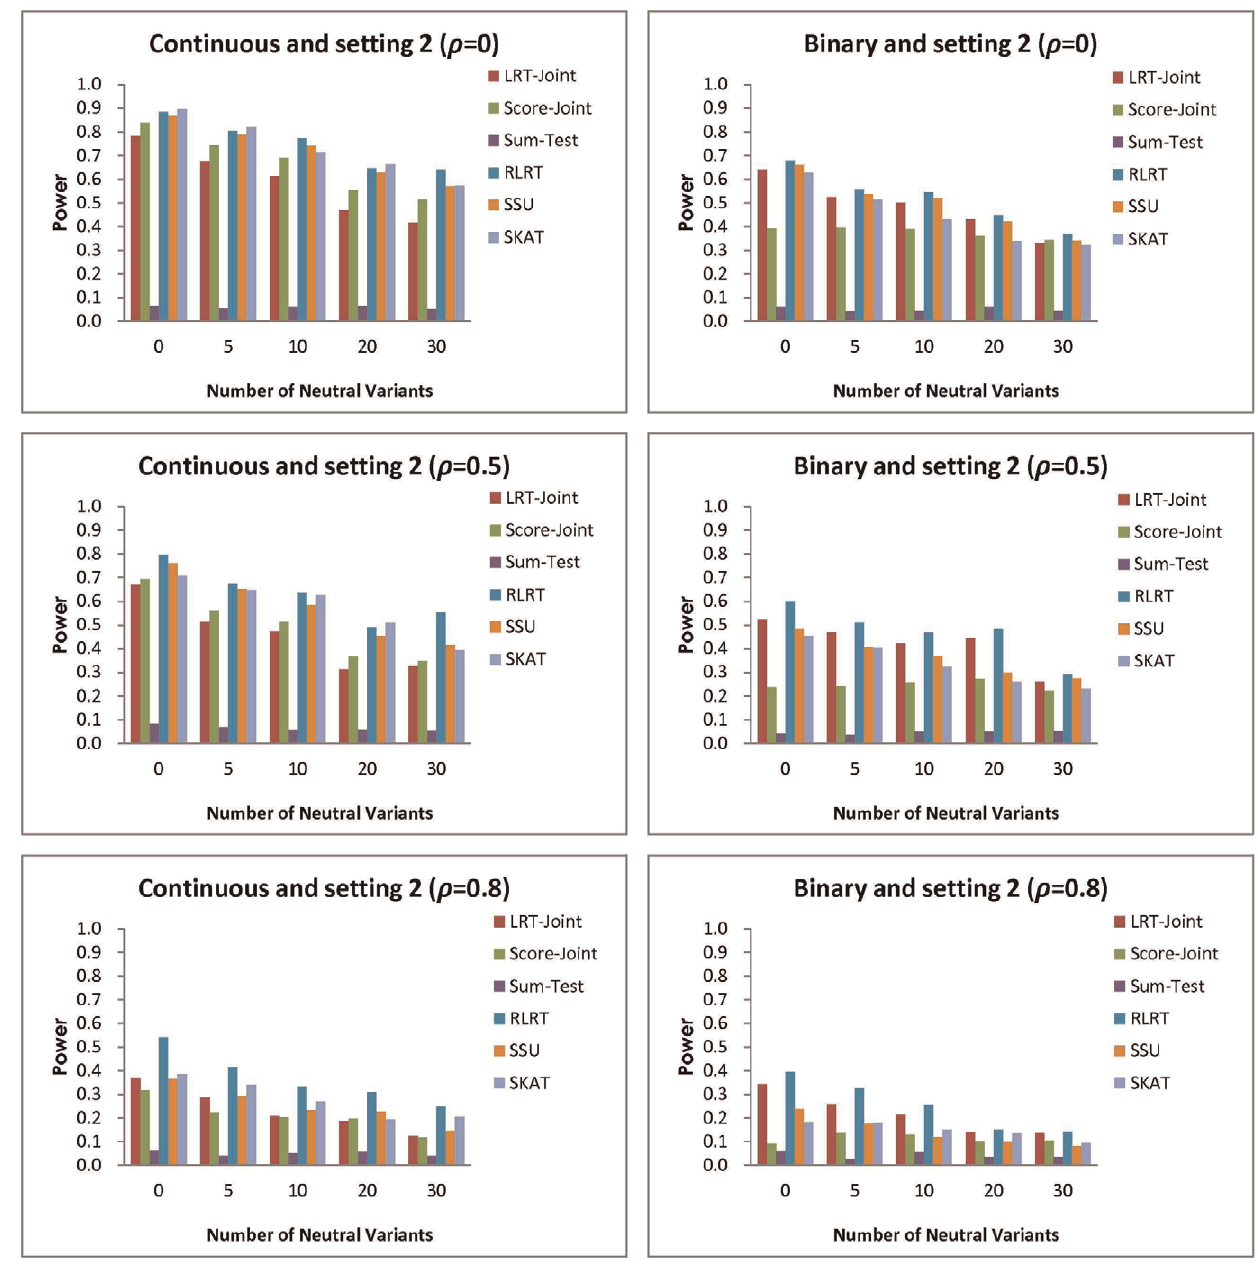
Figure 4. Simulation setting 2: b k ~ ( 0 : 4 , { 0 : 4 , 0 : 4 , { 0 : 4 , 0 : 4 , { 0 : 4 , 0 : 4 , { 0 : 4 , 0 : 4 , { 0 : 4 ) T (continuous trait) and OR ~ ( 2 , 1 = 2 , 2 , 1 = 2 , 2 , 1 = 2 , 2 , 1 = 2 , 2 , 1 = 2 ) T (binary trait).